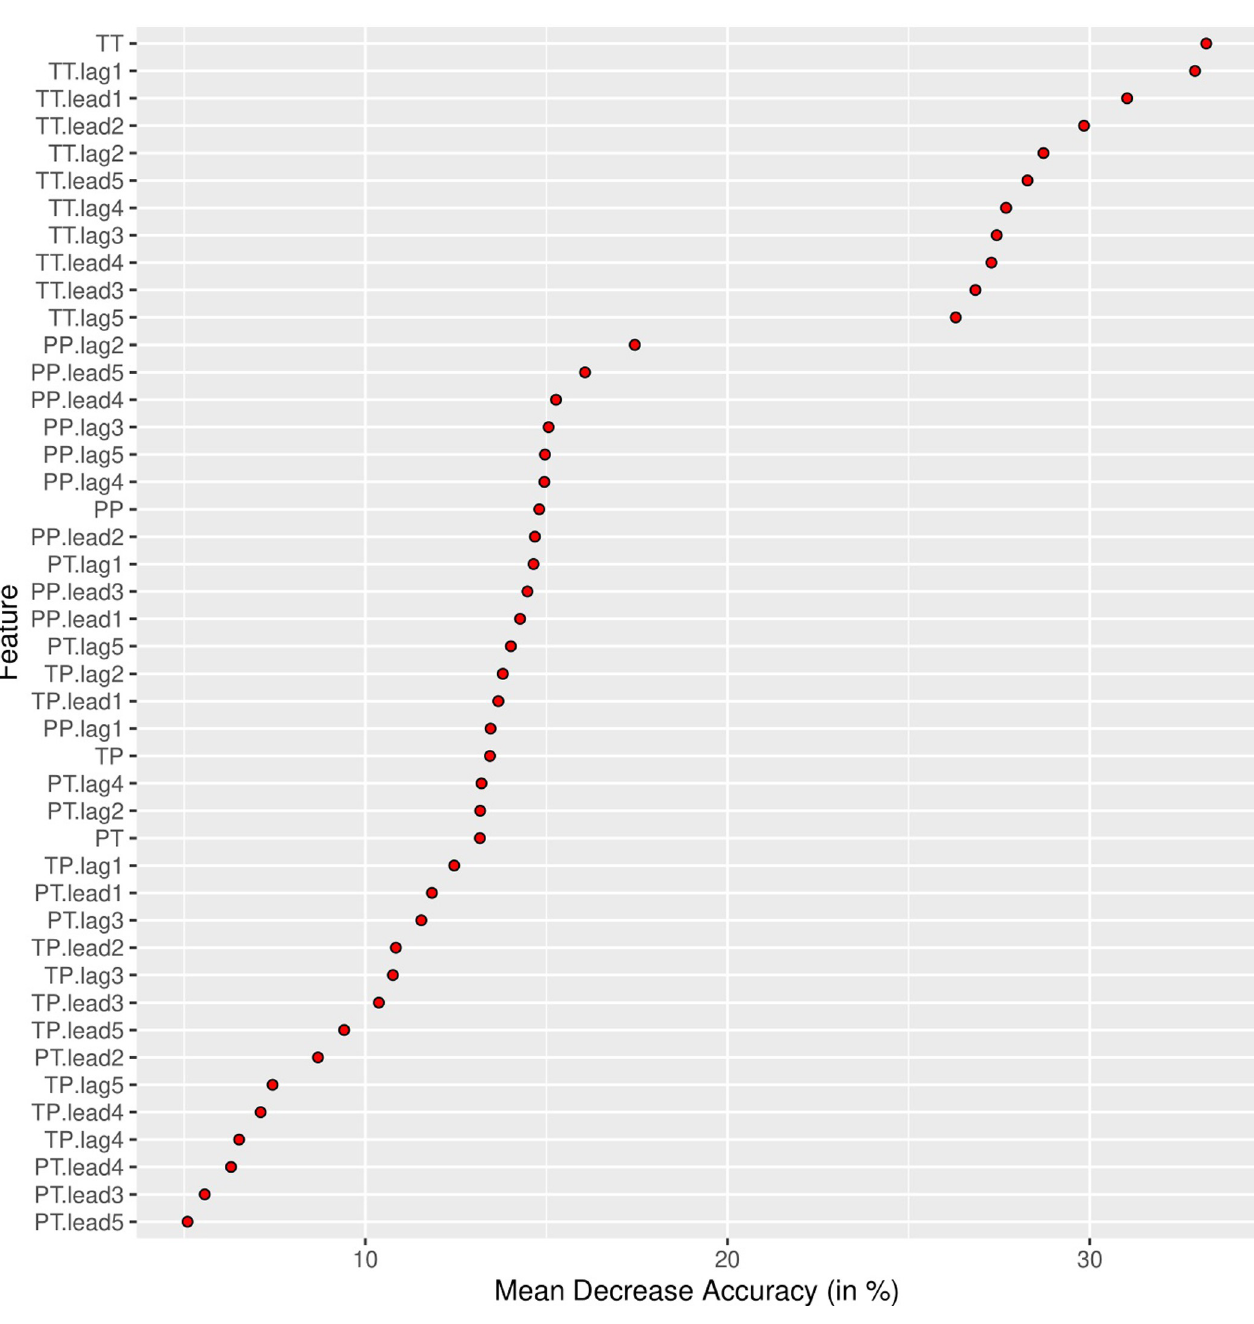
Fig 3. Pause-feature importance for the prediction of minimal response markers. Fig 3 shows the variable importance measure ‘Mean decrease accuracy’ for the predictive model. It indicates the loss of the model’s accuracy in percent if the variable in question is omitted from the training set. For an interpretation, please consider in which order the variables are ranked. The more important variables are listed at the